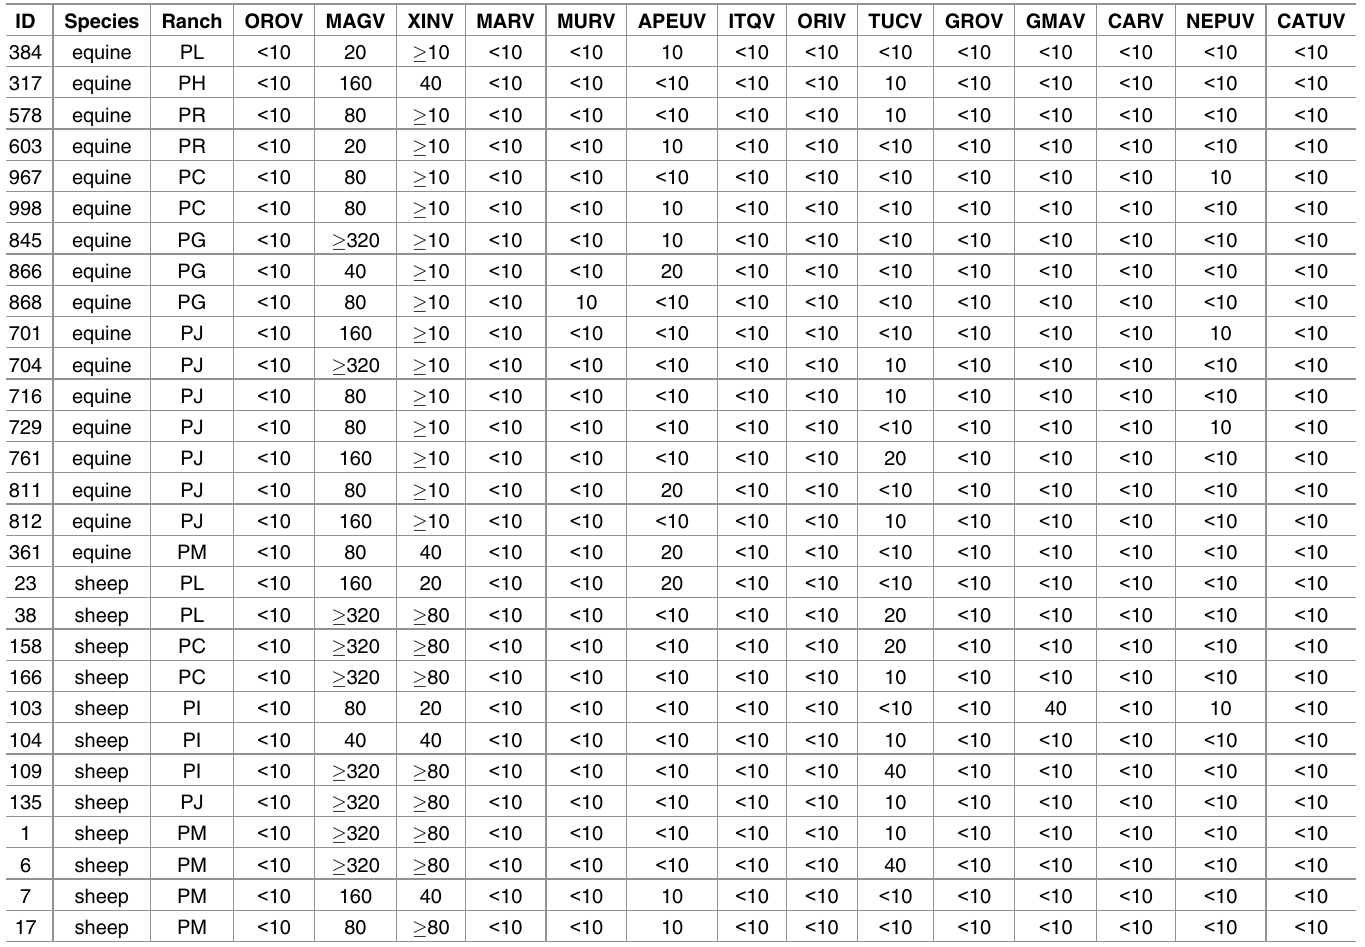
Table 2. Heterotypic reactions by PRNT 90 for more than two orthobunyaviruses in equines and sheep of Pantanal,